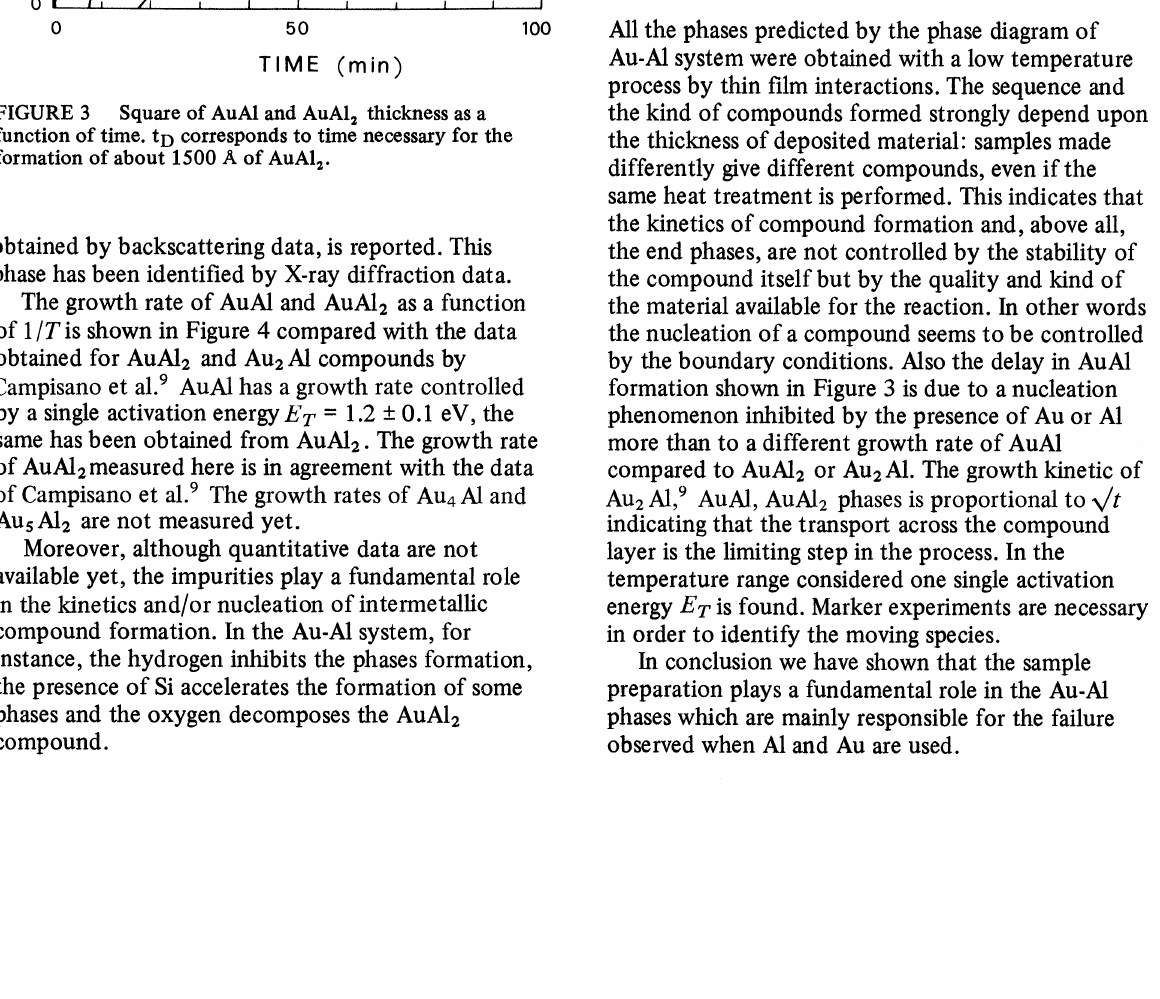
Arrhenius plot of AuA1, AuAI and Au2A1 formation